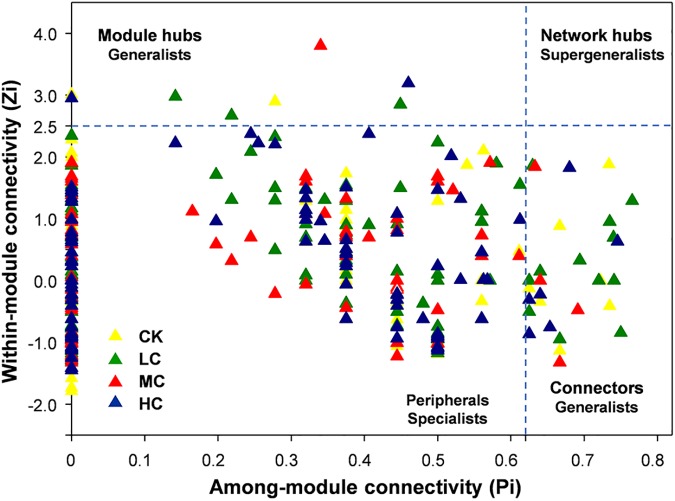
Zi-Pi plot showing the distribution of soil fungal OTUs based on their topological roles. Each triangle represents an OTU in CK, LC, MC, or HC network. See Figure 1 for the abbreviations.